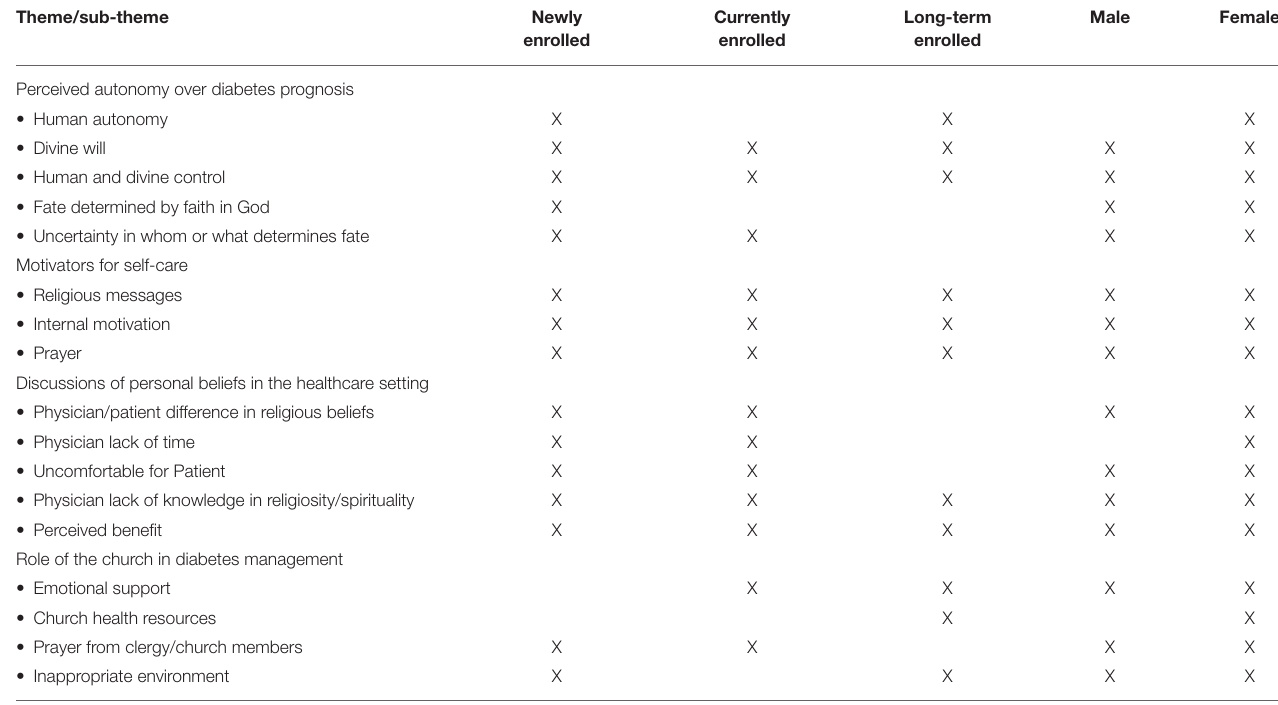
TABLE 3 | Themes related to the role of religiosity and fatalism in Type 2 diabetes management.